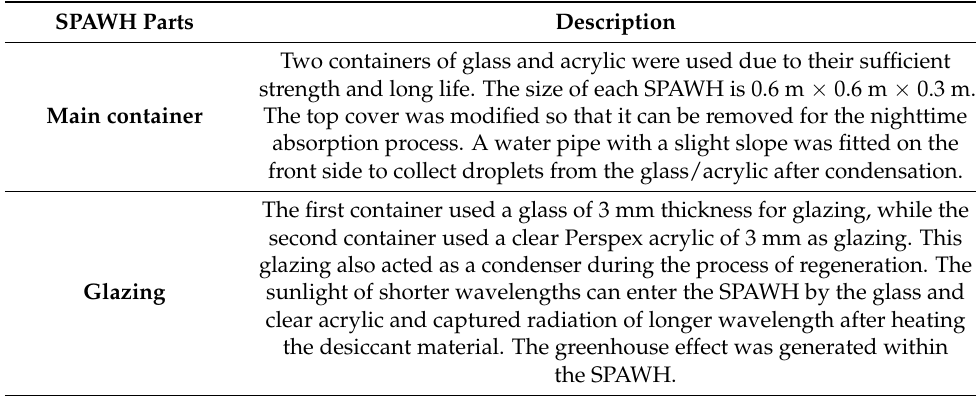
Figure 5. Graphical diagram of the SPAWH.